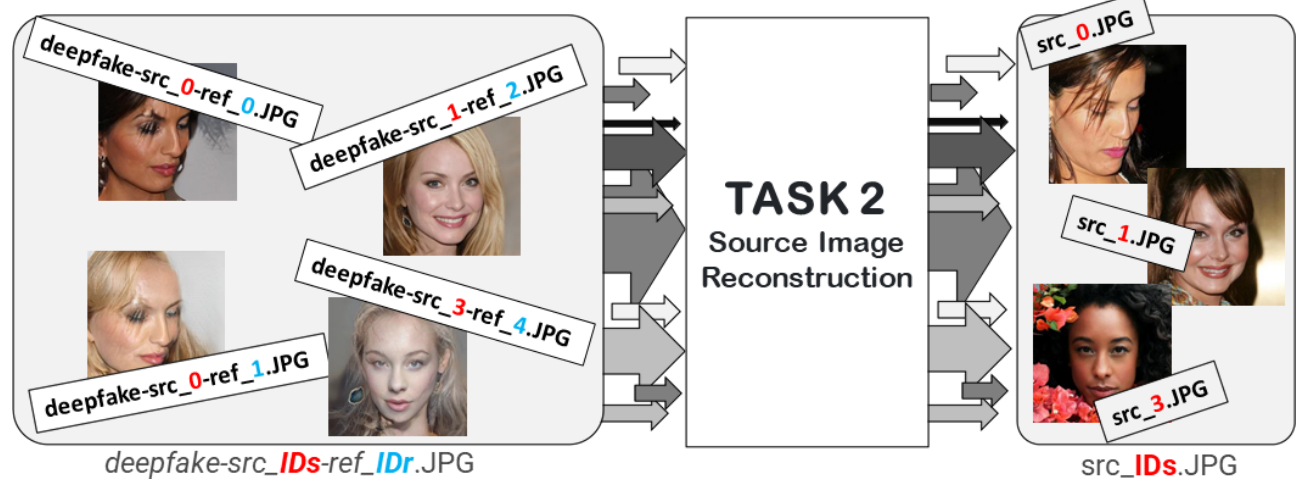
Figure 4. Task II: Source image reconstruction